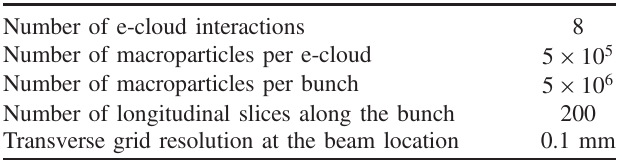
TABLE II. Numerical settings used in the macroparticle simulations.